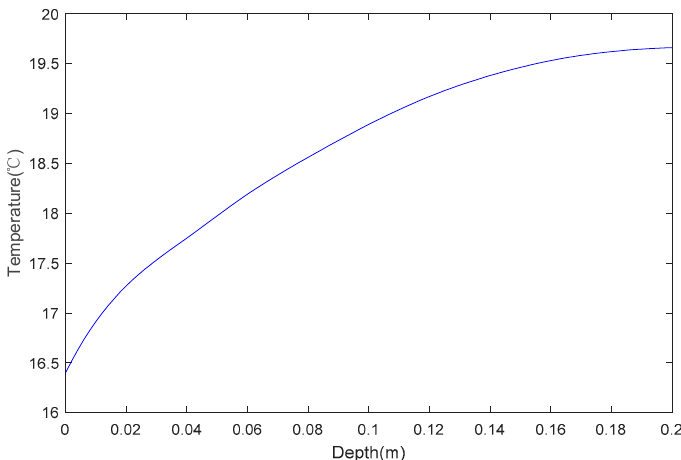
Figure 6. Temperature calculated for the asphalt pavement at 6:00 a.m.